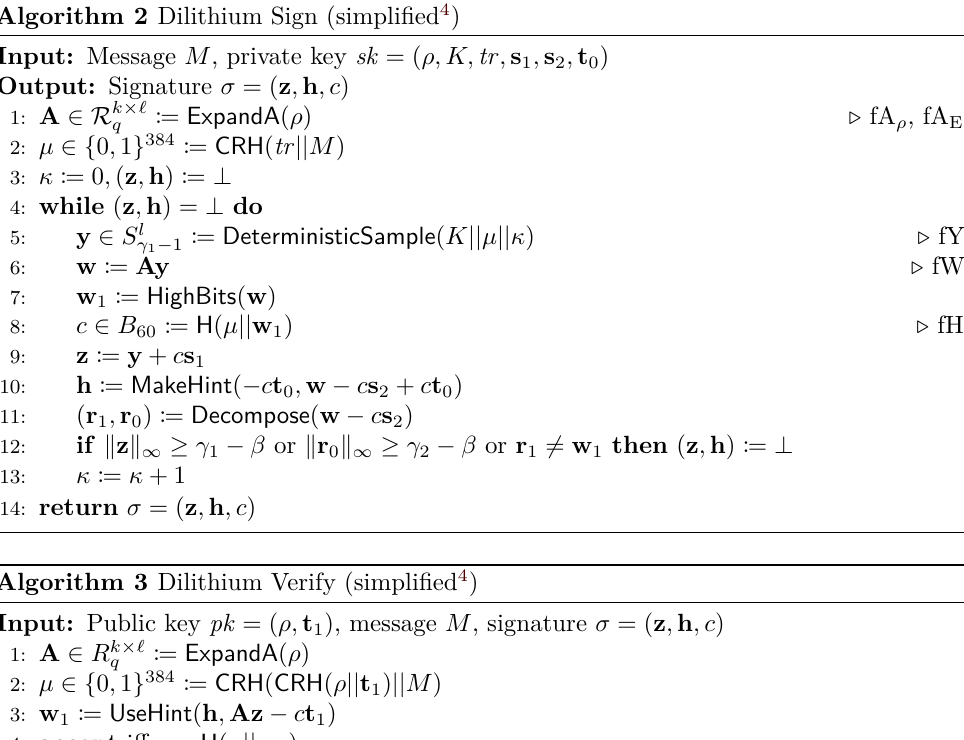
Algorithm 2 Dilithium Sign (simplified 4 )